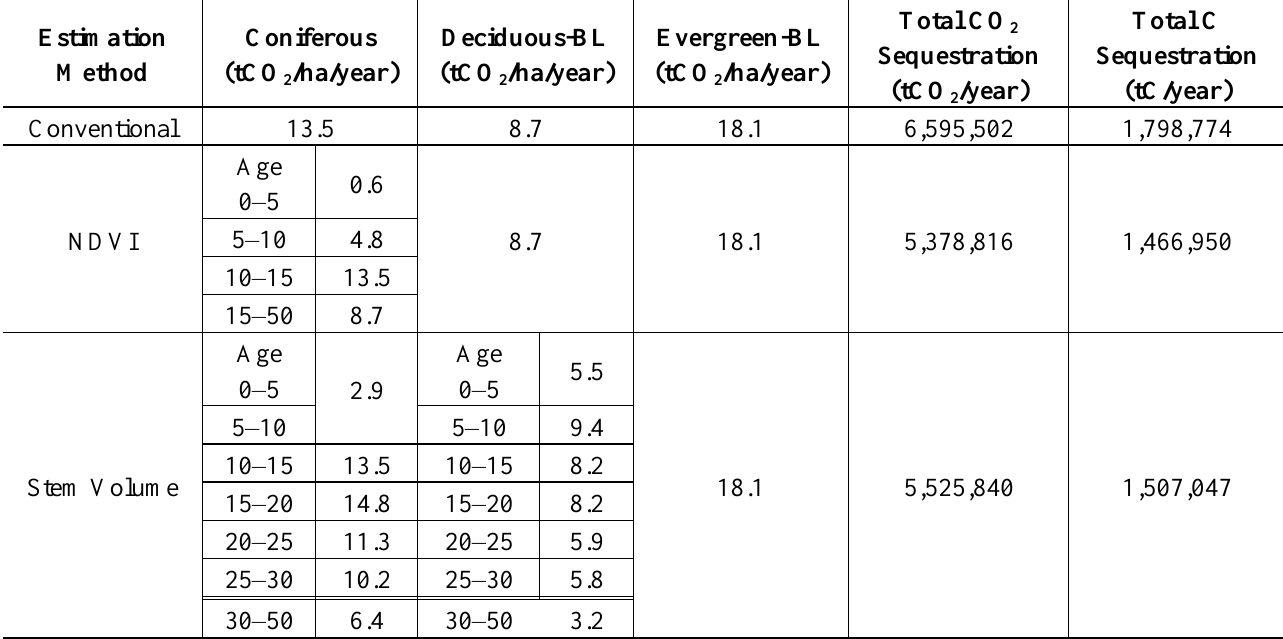
Table 8. Summary of CO sequestration values and total sequestrations for the different 2 methods of